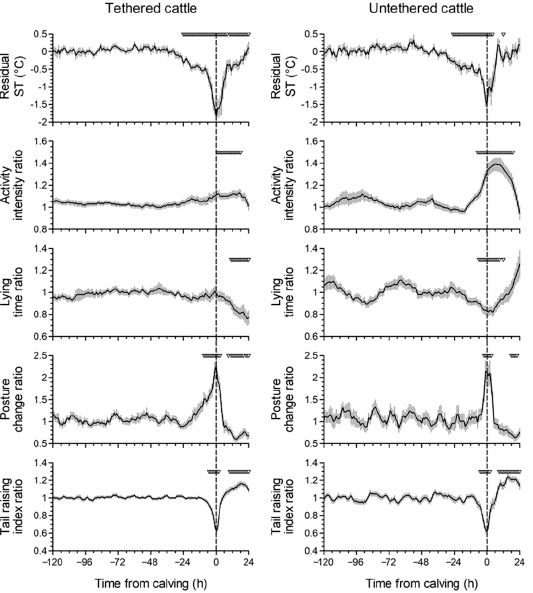
Figure 2. Changes in residual tail skin temperature (rST) and ratios of activity intensity, lying time, posture change, and tail raising index around calving. The rST was calculated as the actual ST − mean ST for the same time on the previous three days. The ratios of activity intensity and lying time were calculated as the total value during the last 24 h/total value during the last 25–48 h. The ratio of posture change was calculated as the average number during the last 6 h/average number during the last 7–30 h. The ratio of tail raising index was calculated as the average value during the last 3 h/average value during the last 4–27 h. Data were standardized to actual calving time (0 h: dashed vertical line). Inverted triangles indicate the time points with significant differences between the mean values at the indicated time points and the mean values during the reference period ( − 240 h to − 121 h from calving) ( p < 0.05). Data are expressed as the mean ± standard error (n = 33 and 30 in tethered and untethered cattle, respectively).